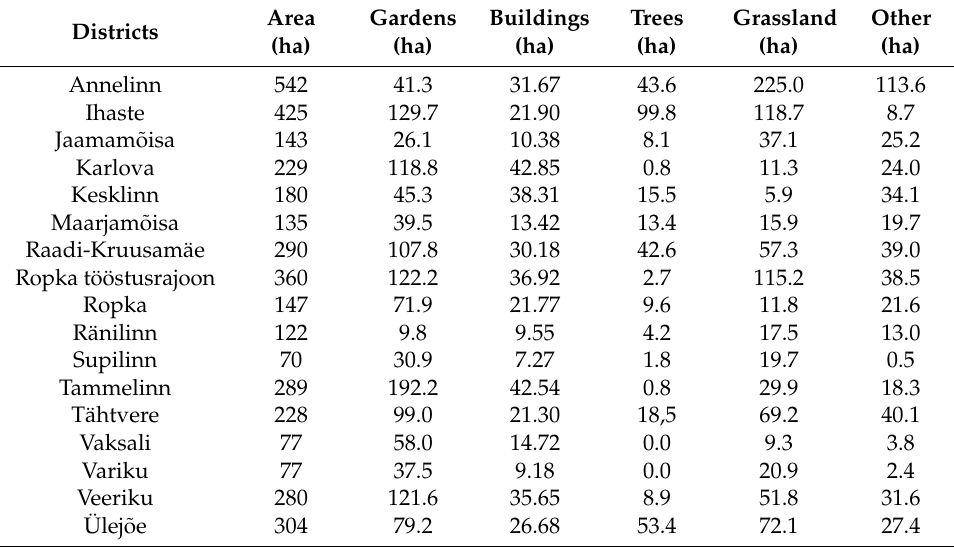
Table 1. Area of land use per district of Tartu, Source: Estonian Land Board. Area Districts (ha)